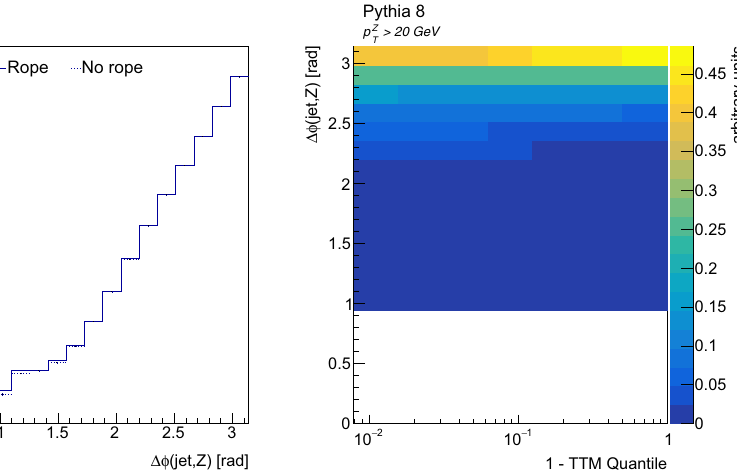
Fig. 7 Left:Theazimuthalanglebetweenthehardjetandthe Z boson. Most events are nearly back-to-back; events are vetoed in the region where there is a strong additional recoil (even if it does not form a jet